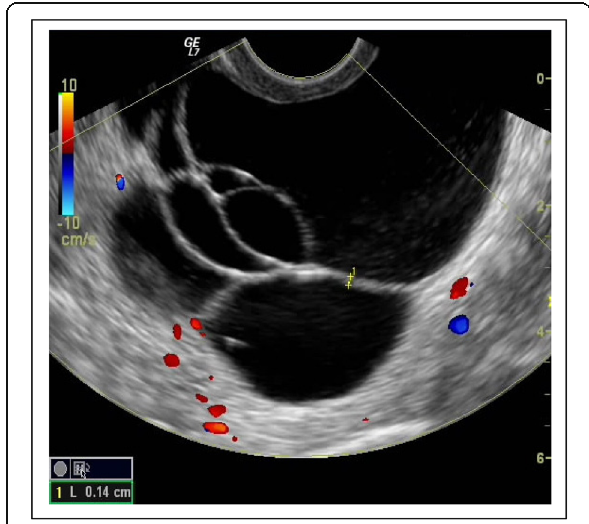
Fig. 5 GI-RADS 3, false-negative case diagnosed by histopathology as serous cystadenocarcinoma. By transvaginal ultrasound, well defined, thin walled, thin septa, no papillary projections, no solid